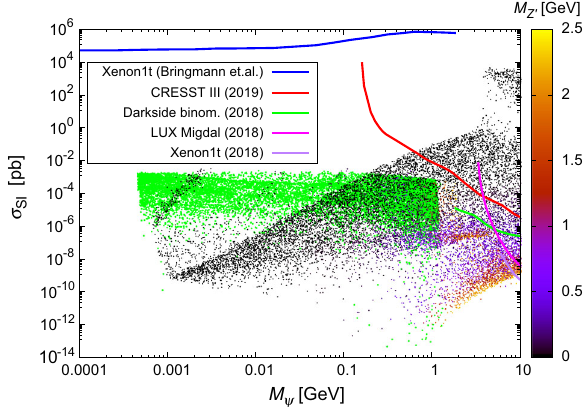
Fig. 3 TheDM-nucleoncrosssectionsfortheparametersetssatisfying the relic abundance. Green points denote the resonant region for DM annihilation and points of other colors the nonresonant annihilations depending on the Z (cid:2) and h 1 masses